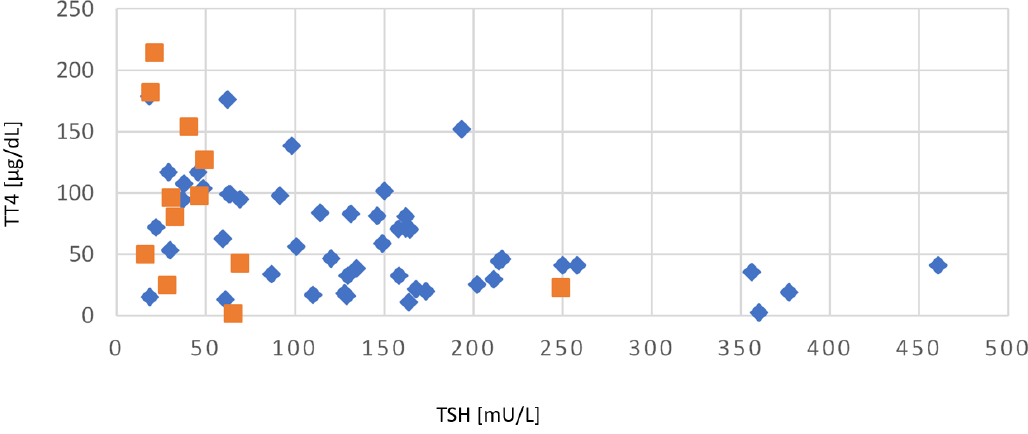
Figure 7. Correlation of whole blood TSH and TT4 values from patients with CH at birth. ♦ pCH ■ tCH.